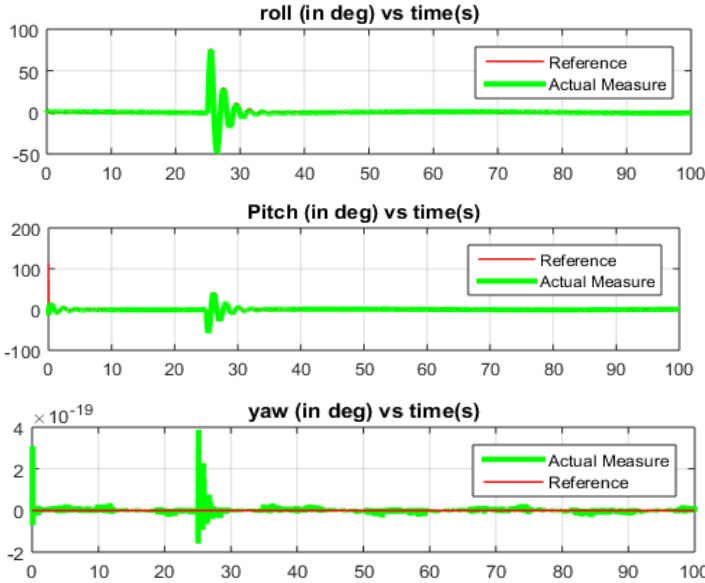
Figure 11. Roll, pitch and yaw responses using SMC Control technique.